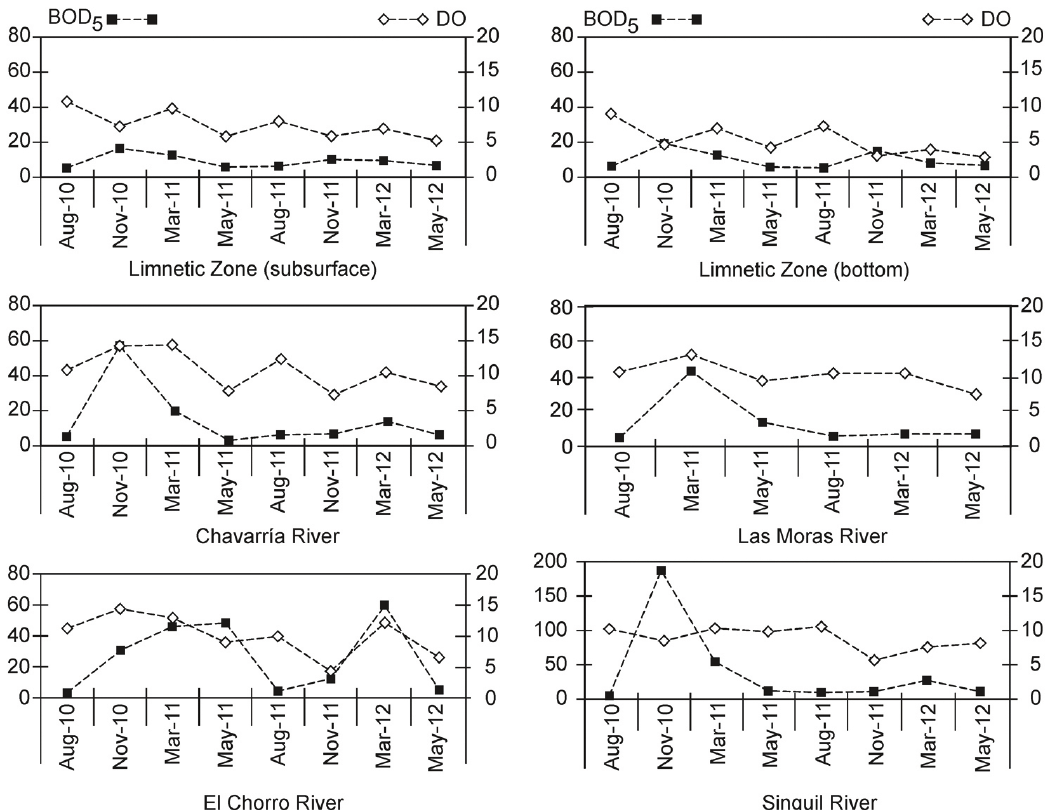
Figure 5. Variation in dissolved oxygen (DO) (mg.L –1 ) and biochemical oxygen demand (BOD